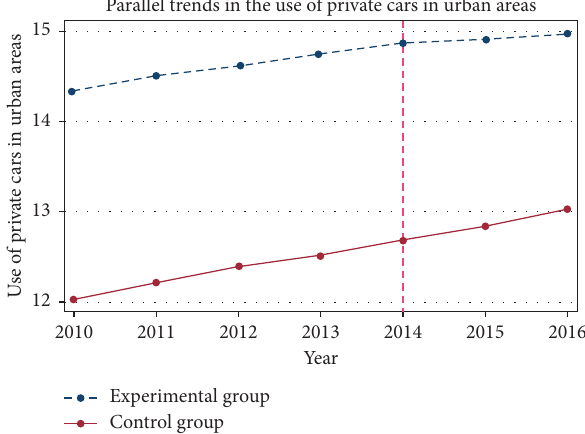
Figure 1: Parallel trend test of private car use in experimental and control